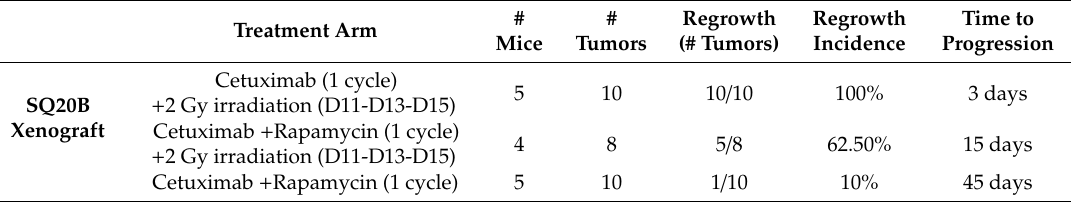
Table 2. Cetuximab and radiotherapy accelerates tumor relapse in nude mice bearing SQ20B xenografts. Nude mice bearing SQ20B cells were randomized to 3 treatments arms: (i) cetuximab (1 cycle: